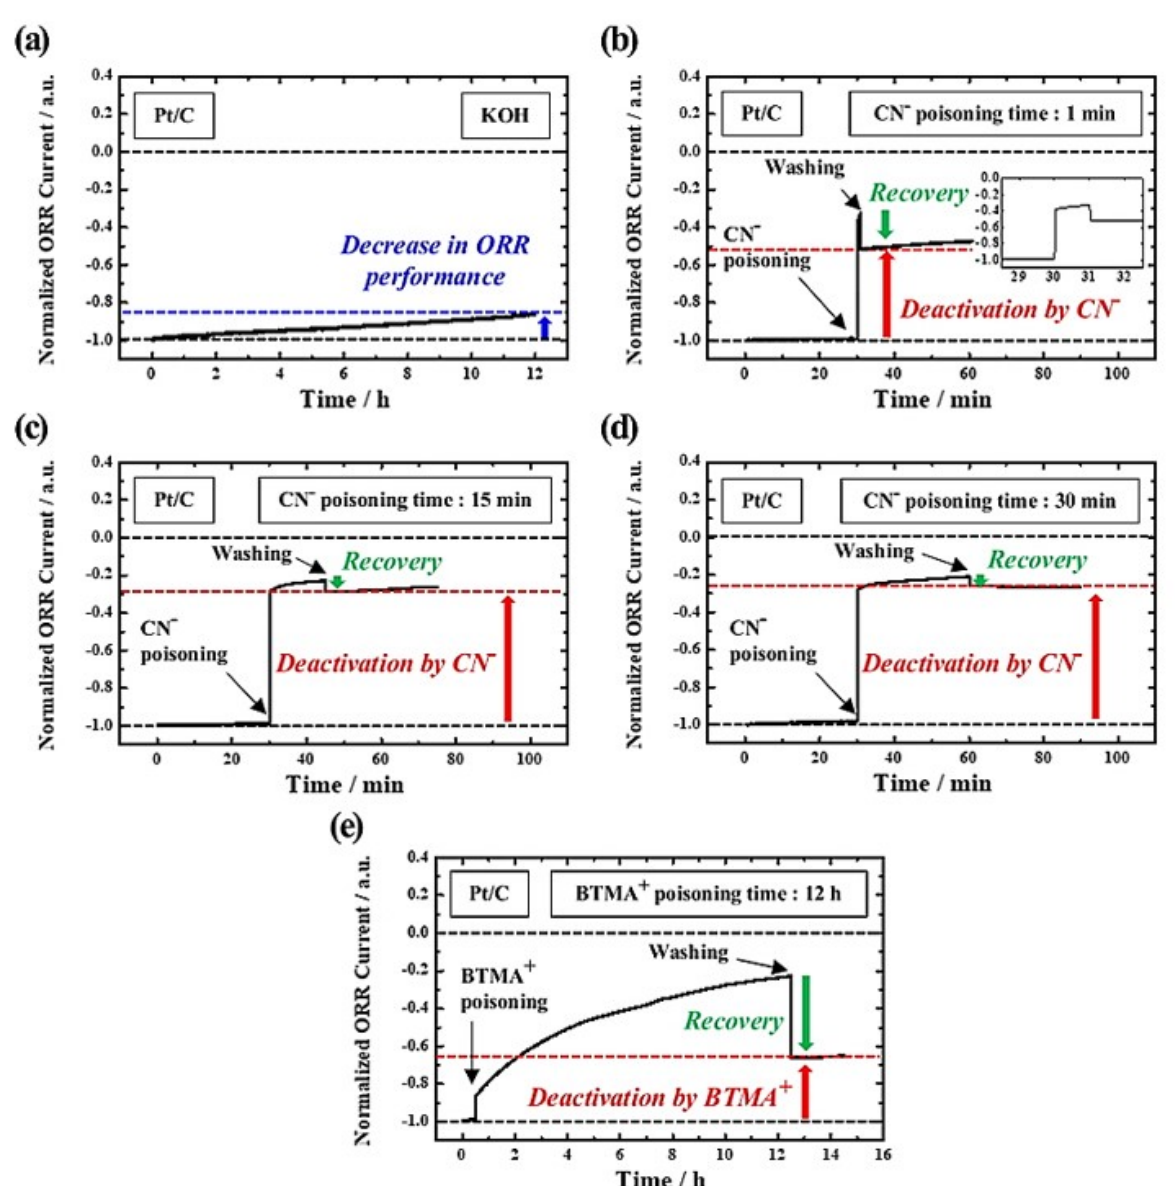
Figure 4. Chronoamperograms of Pt/C at 0.7 V in O 2 − saturated ( a ) 0.1 M KOH, ( b – d ) 0.01 M KCN − mixed 0.1 M KOH, and ( e ) 0.1 M BTMAOH. The inset of ( b ) shows an enlarged chronoamperogram of the corresponding data.